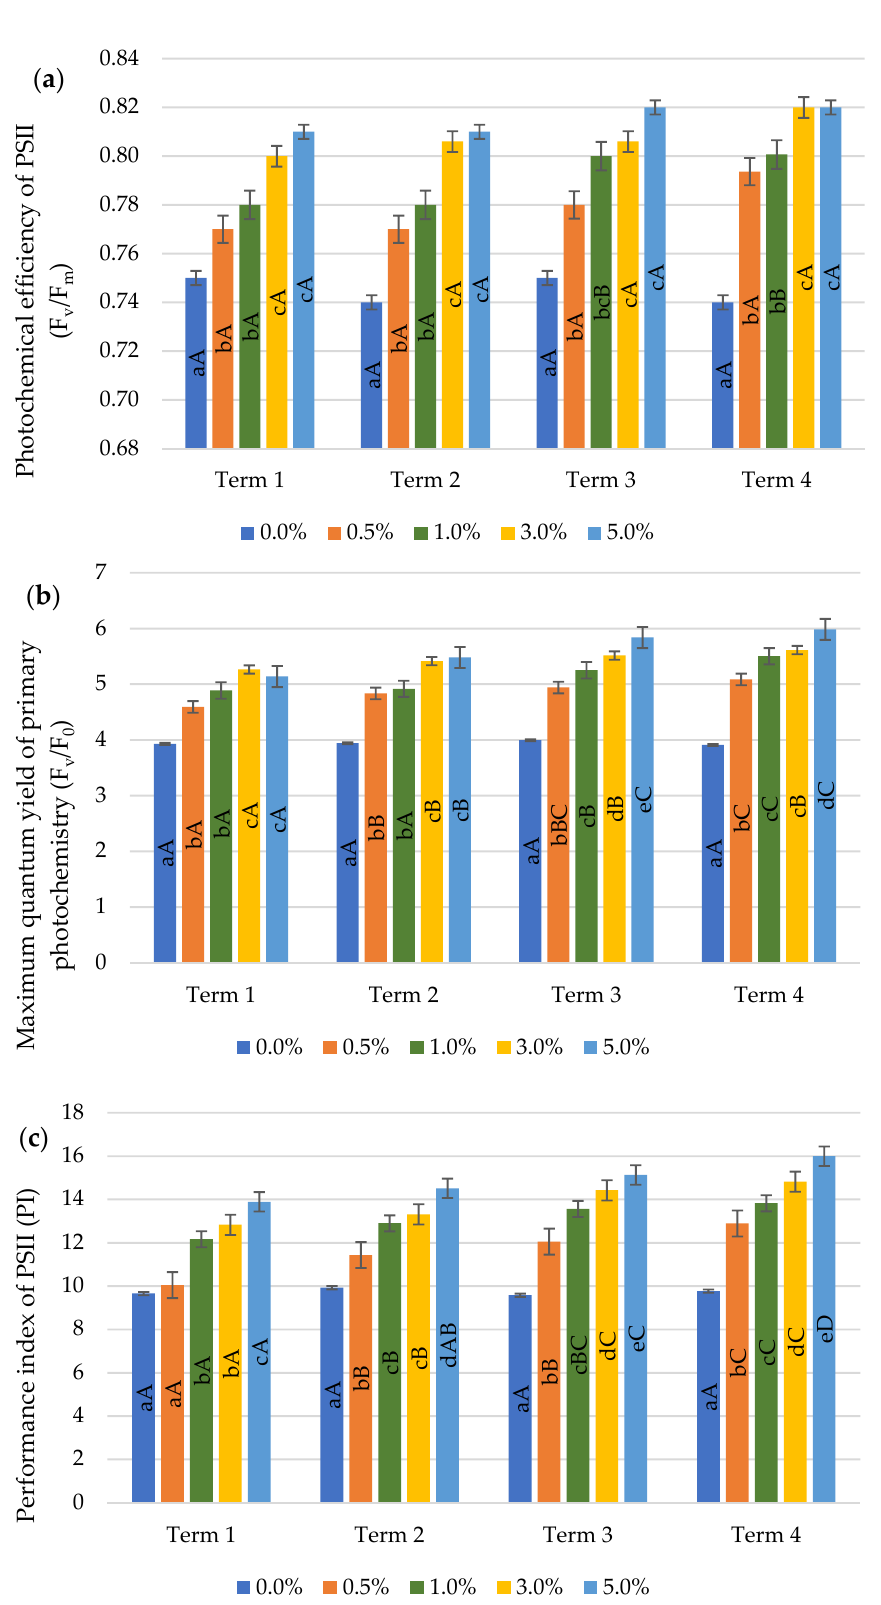
Figure 4. Effect of quercetin derivative concentrations and terms of measurement on chlorophyll fluorescence parameters: ( a ) photochemical efficiency of PS II (F v /F m ); ( b ) maximum quantum yield of primary photochemistry (F v /F 0 ) and ( c ) performance index of PS II (PI). (Term 1—first day after the first treatment, Term 2—seventh days after the first treatment, Term 3—first day after the second treatment, Term 4—seventh days after the second treatment). Capital letters indicate significant dif-